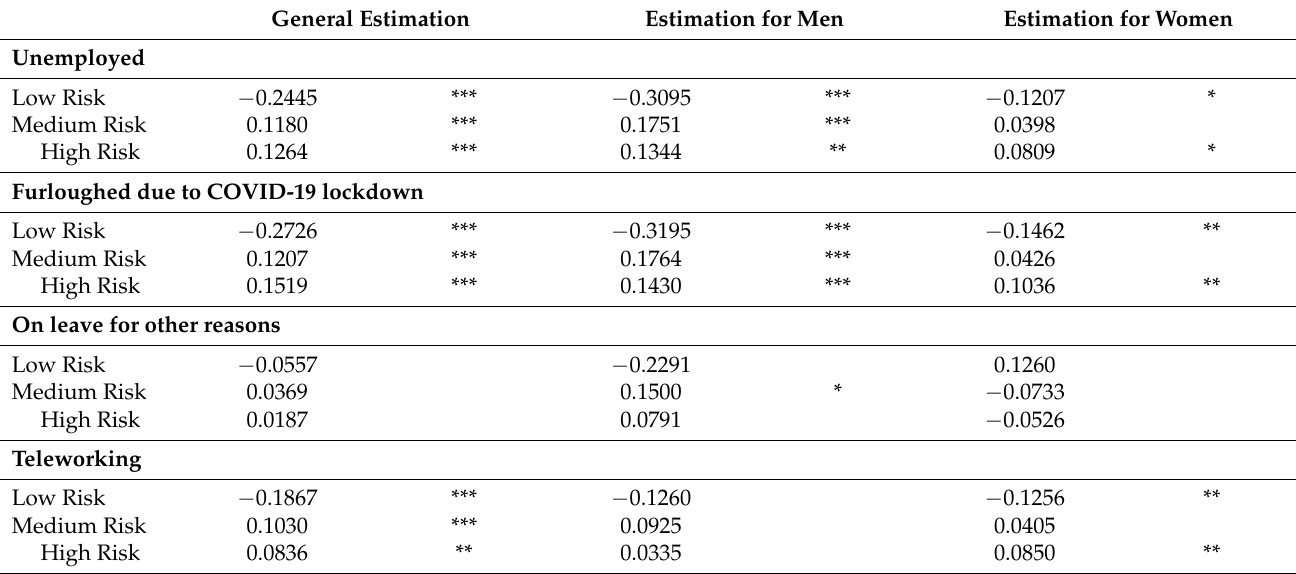
Table 4. Marginal effects for work-related situations (ref: working at the usual